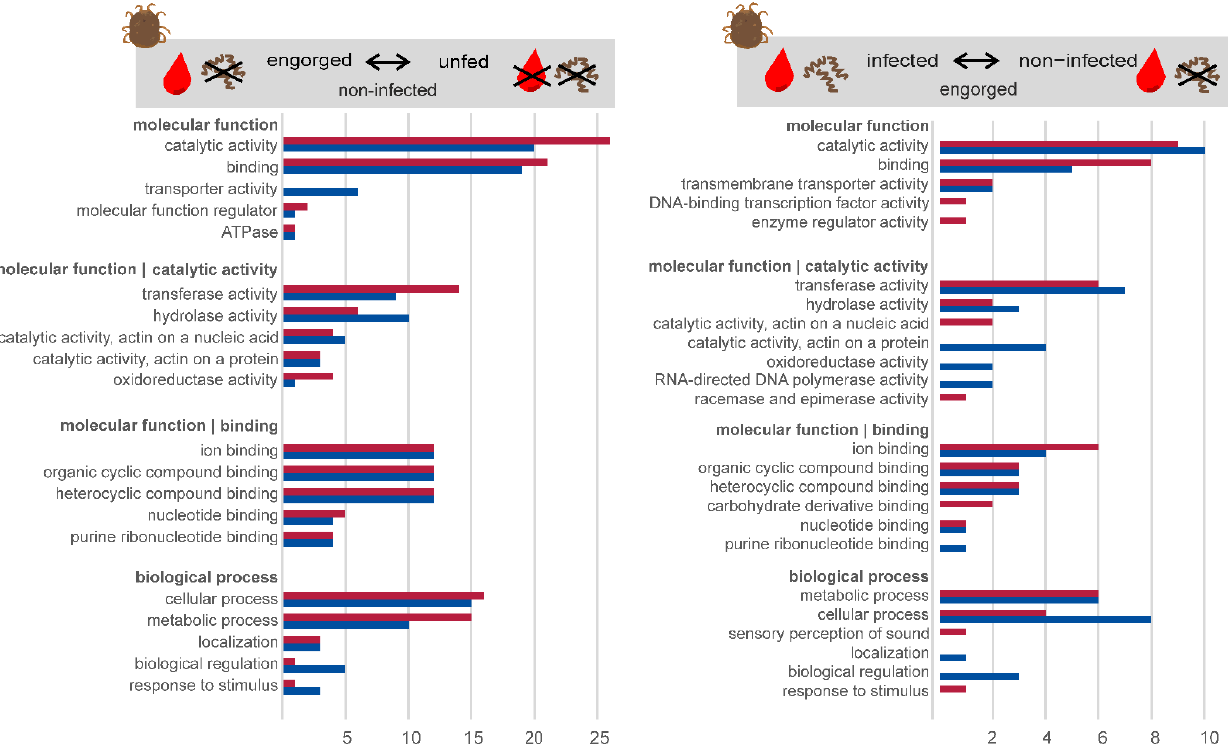
Figure 4. Classification of differentially expressed transcripts. Gene ontology annotation of up-regulated (red) and down-regulated (blue) transcripts in the midgut of O. moubata in the comparison “engorged vs. unfed—non-infected”, and “ Borrelia duttonii -infected vs. non-infected—engorged”. The categories molecular function and biological process are shown.